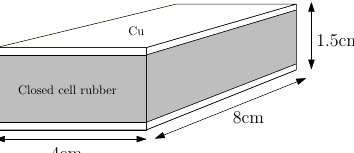
Figure 2: Electrode detail. The dimensions were chosen to approximate the prototype transciever construction.